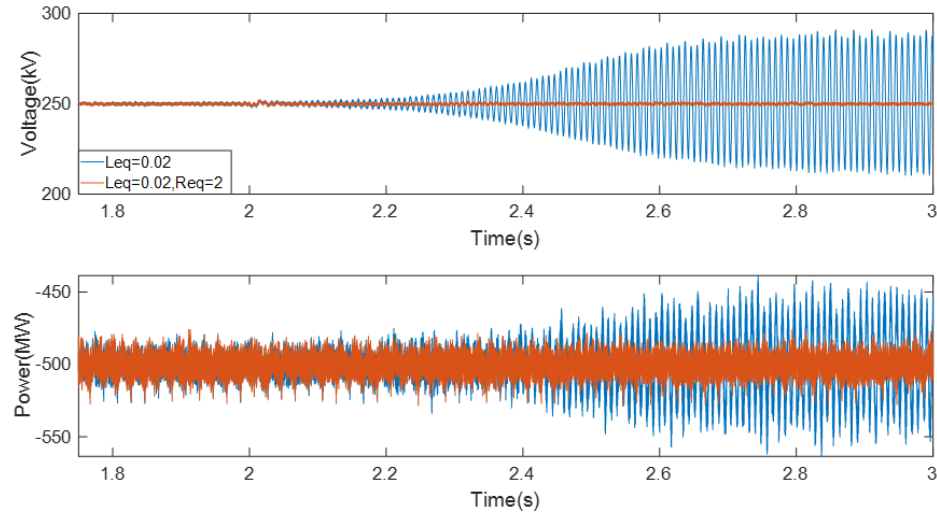
Figure 18. DC-link voltage and active power of the VSC – HVDC system under different gird impedance.